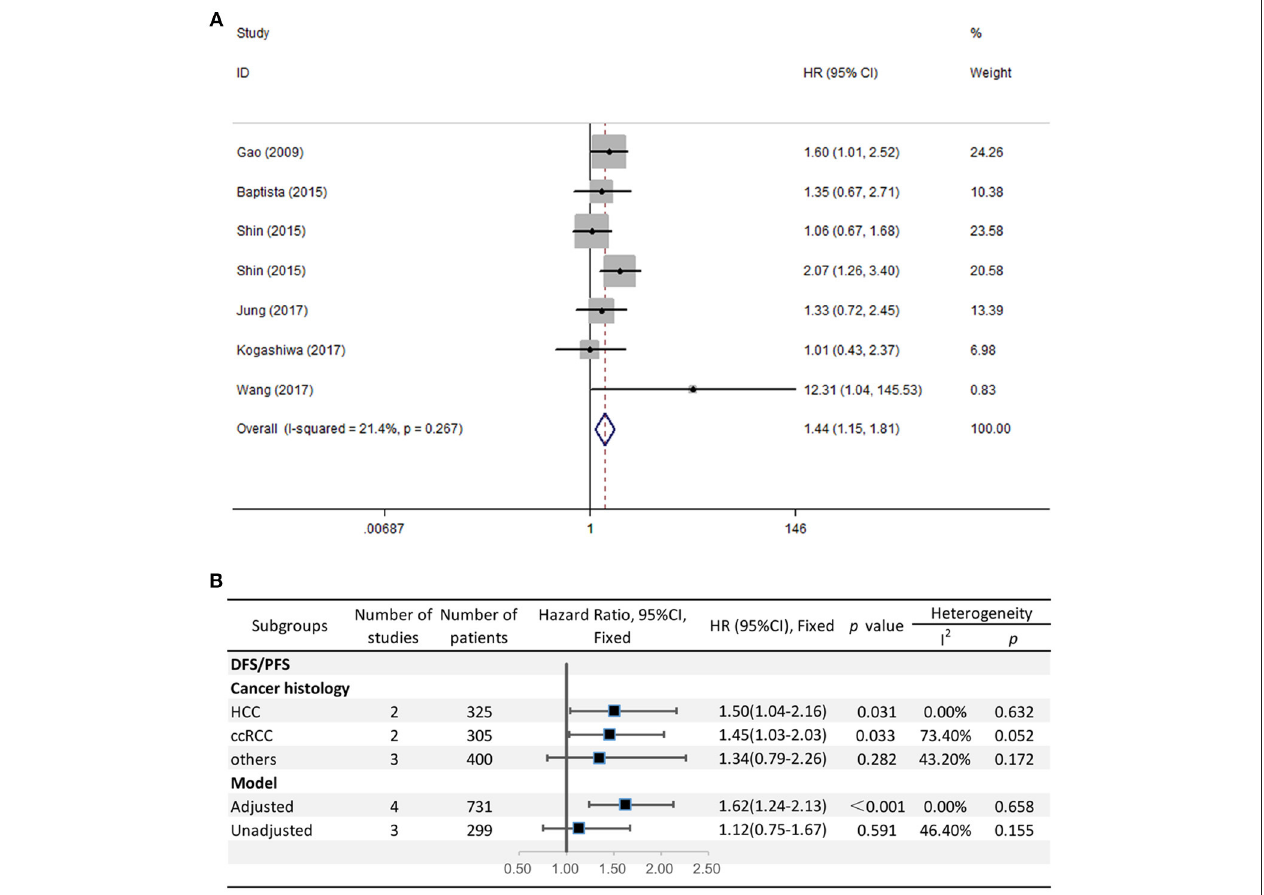
FIGURE 3 | (A) Meta-analysis of the association between PD-L2 expression and DFS/PFS among solid cancer patients after surgery; (B) Subgroup analyses of the correlation between PD-L2 and